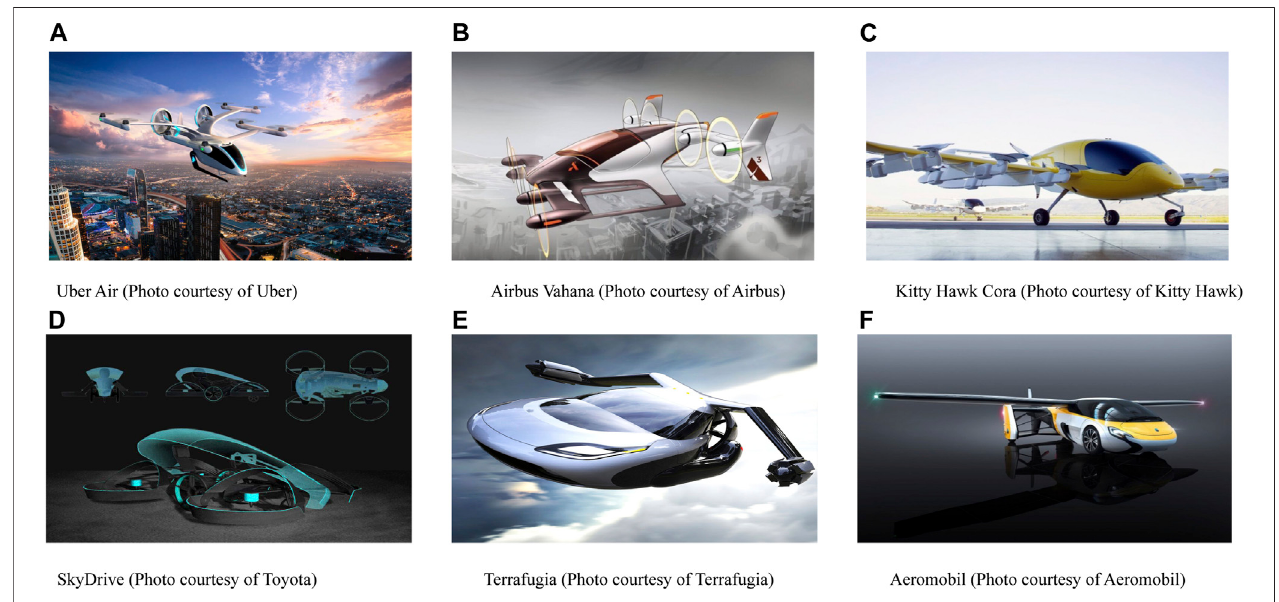
FIGURE 1 | Some ongoing projects using eVTOL technology for urban air